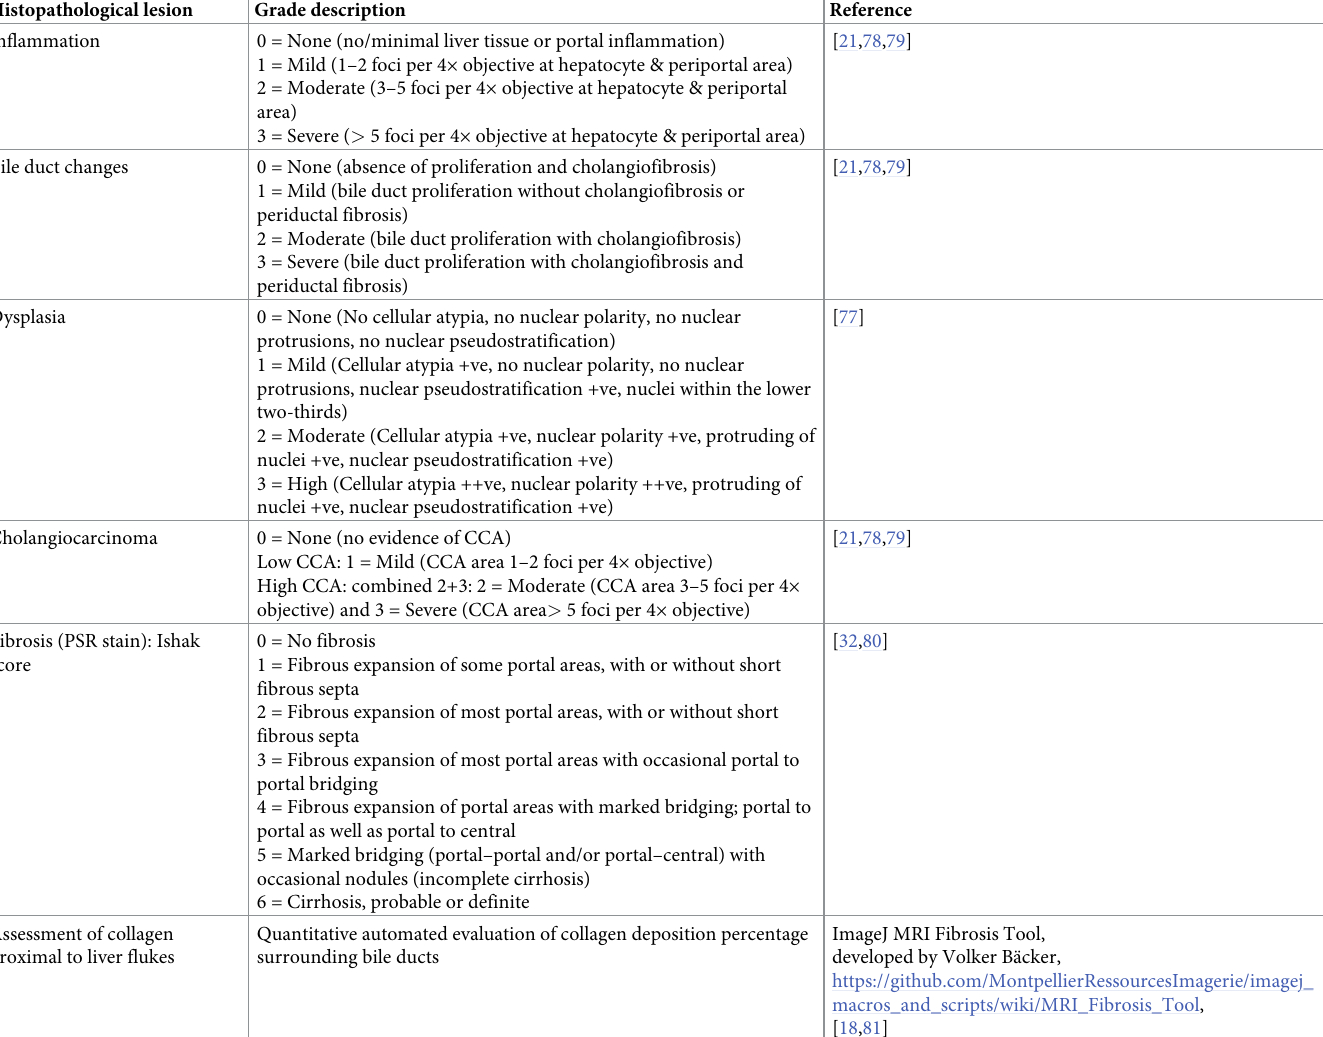
Table 1. Criteria for histopathological and histochemical assessment and grading. Histopathological